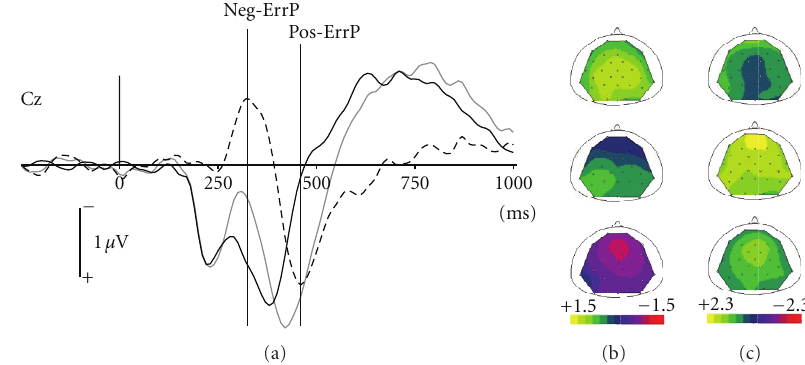
Figure 7: Grand average event-related dynamics ( − 250 ms to 1000ms, channel Cz) associated with responses to correct feedbacks (black solid line), responses to incorrect feedbacks (grey solid line), and the di ff erence between the two (black dashed line) (a). Zero time corresponds to feedback onset. Topographies for correct (top), incorrect trials (middle), and their di ff erence (bottom) correspond to the latencies of the peaks of the neg-ErrP (b) and pos-ErrP (c), respectively.